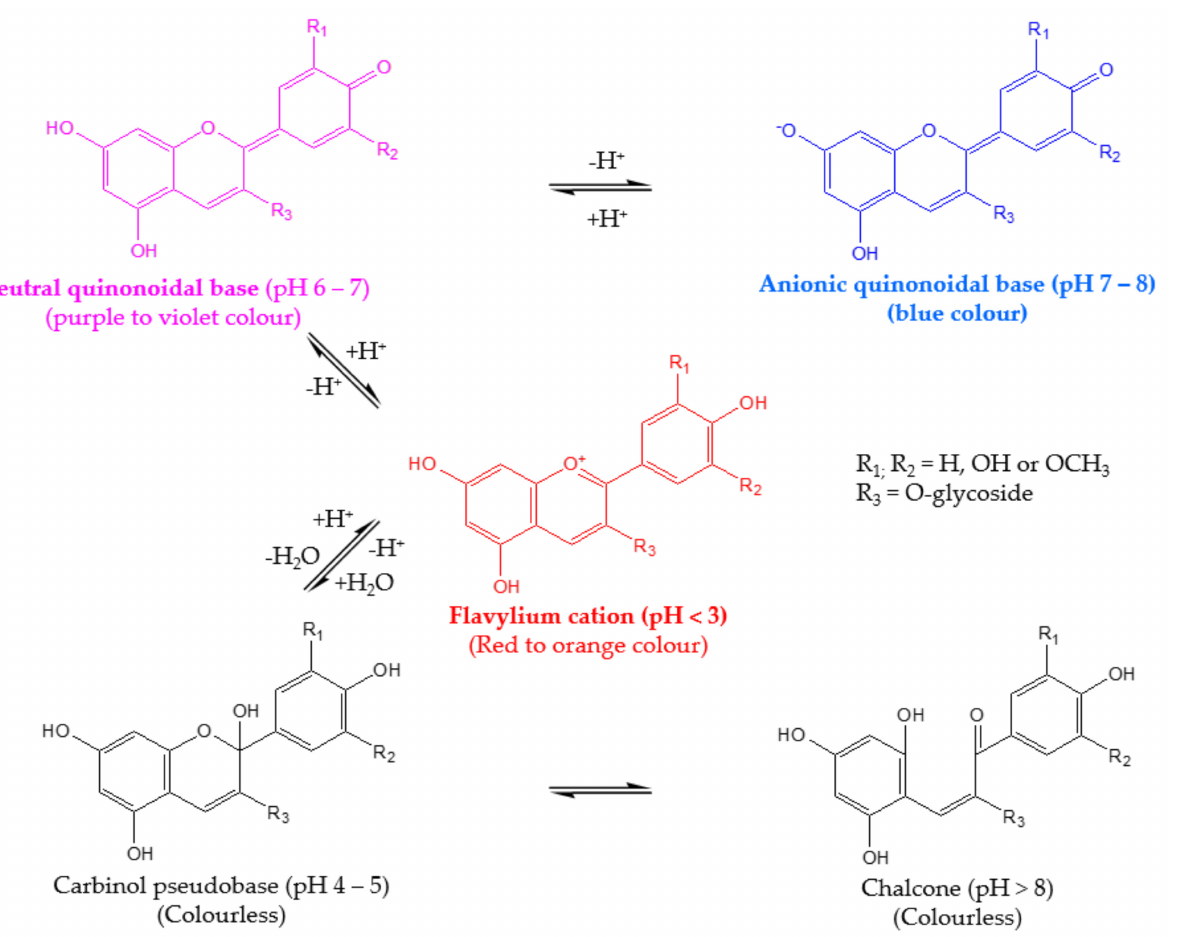
Figure 1. Effect of pH on the structural transformation of anthocyanins and the resulting color. Adapted from Houghton et al.